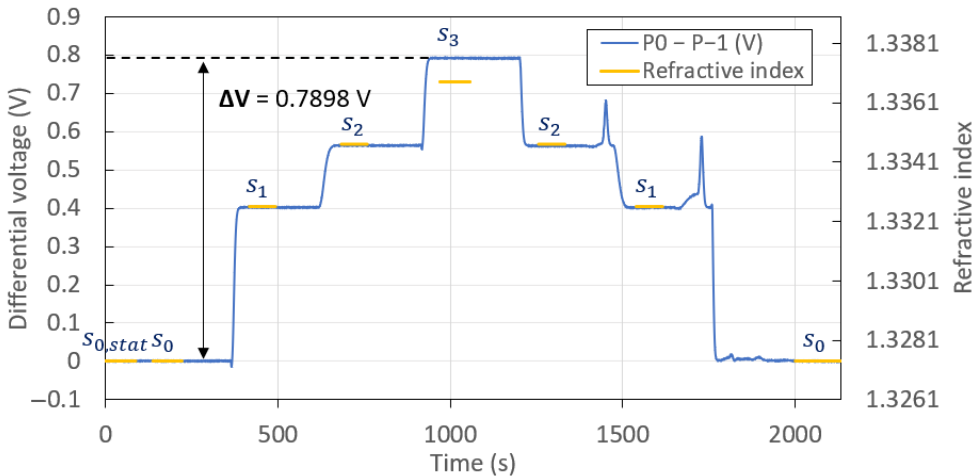
Figure 5. Response of the plasmonic grating with the profile illustrated in Figure A2a, to the sequential injection of solutions (glycerol in water) of RI summarized in Table 1 at the angle of incidence θ l (left working point) and a continuous flow rate of 160 µL/min. The injection of all solutions except for s 3 was cycled once to demonstrate repeatability. The step associated with solution s 0, stat corresponds to the solution s 0 under static conditions (syringe pump off). The steps associated with the solutions of different RI correspond to the time over which the solutions were injected. The RI calculated at λ 0 = 850 nm from those measured at λ 0 = 1312 nm (reported in Table 1) is shown as the yellow horizontal lines for